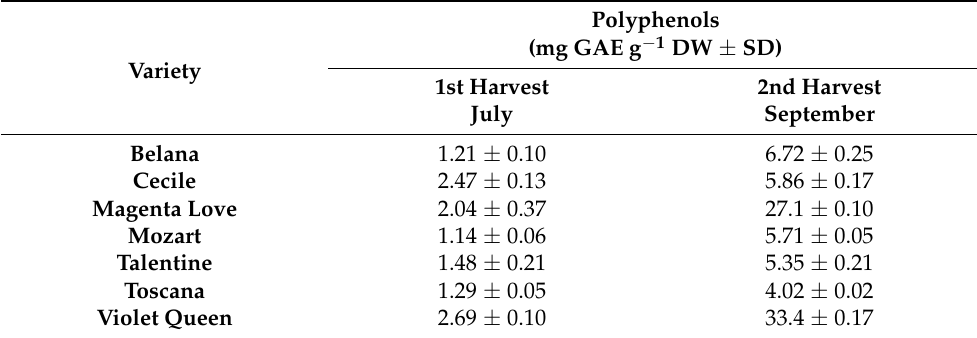
Table 3. Total polyphenol contents in seven potato varieties depending on variety and harvesting